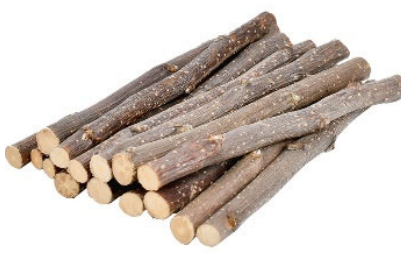
Figure 1. Apple tree branches samples.